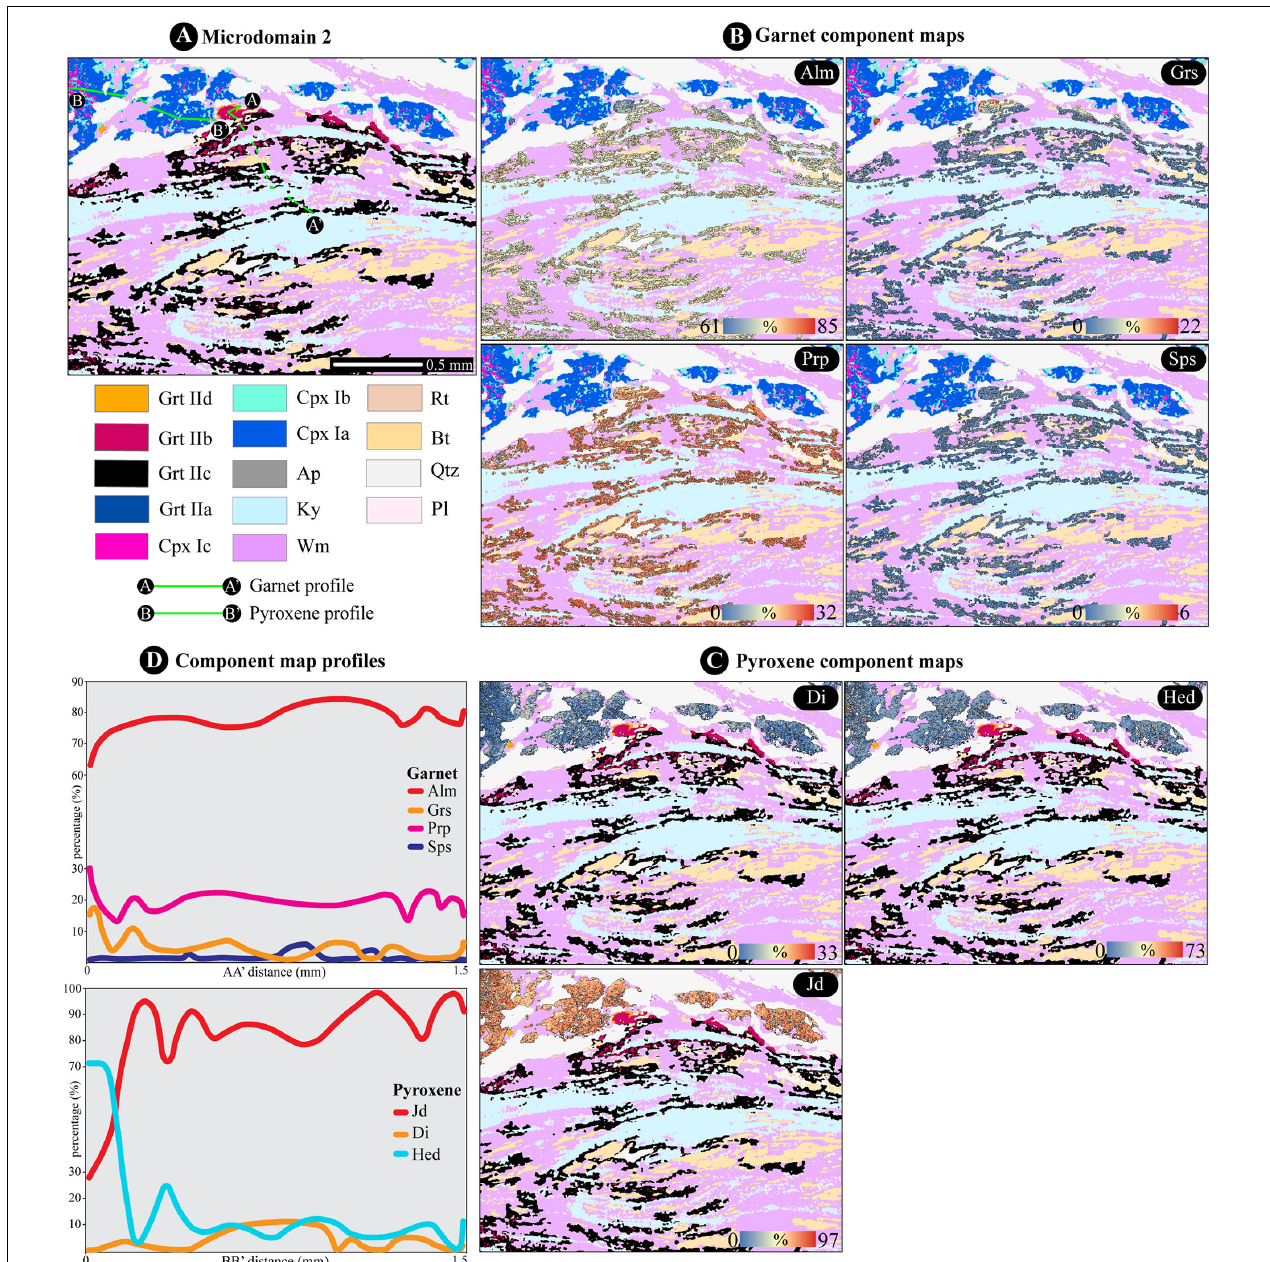
FIGURE 10 | (A) Results of third cycle of Q-XRMA for pre-alpine Sill microdomain and localization of chemical profiles. (B) Component maps for Grt (i.e., Alm, almandine; Grs, grossular; Prp, pyrope; Sps, spessartine). (C) Component maps for Cpx (i.e., Di, diopside; Hed, hedenbergite; Jd, jadeite). (D) Component profiles for Grt and